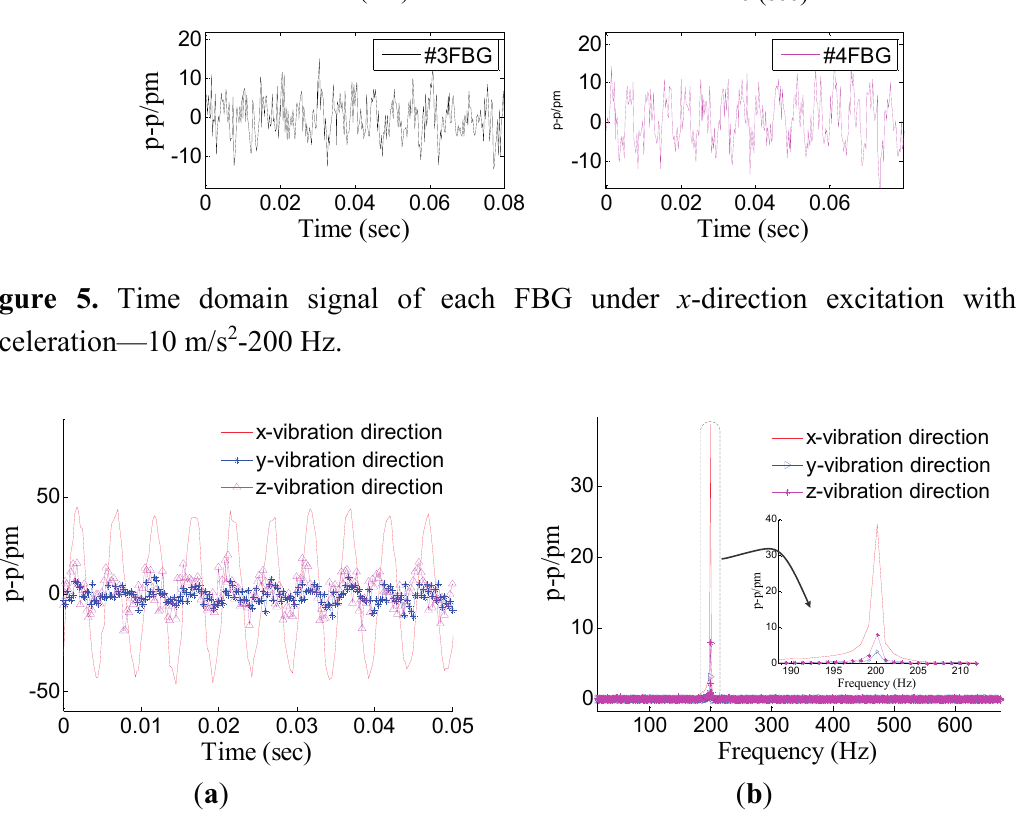
Figure 6. Response of the three directions under x -direction excitation with the acceleration—10 m/s 2 -200 Hz. ( a ) Time domain response map. ( b ) Spectrum